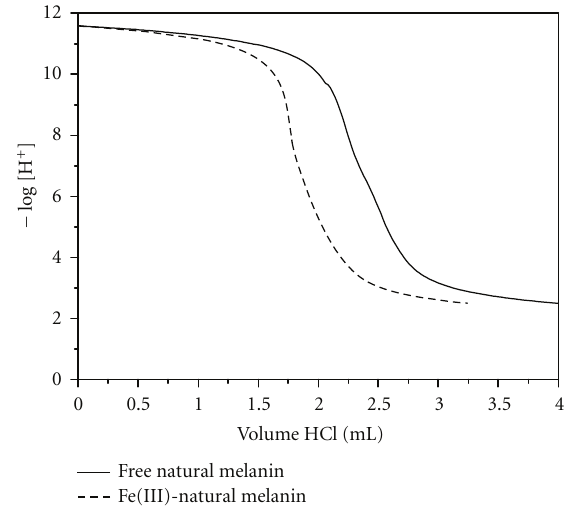
Figure 5: The titration curves for natural melanin in the absence and presence of Fe(III).